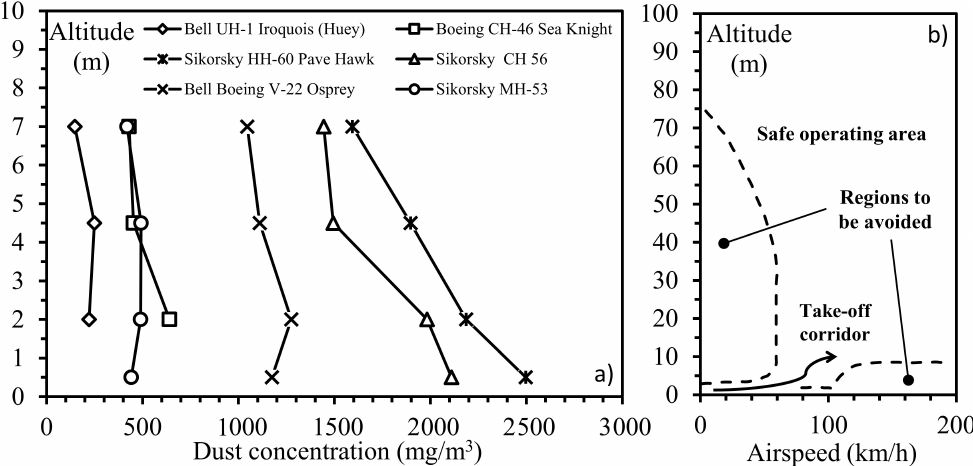
Figure 1. Operative conditions of a rotorcraft: ( a ) dust concentration profiles over altitude for six helicopter frames [8]; and ( b ) qualitative reproduction of the height-velocity curve of the Sikorsky S-76 helicopter, adapted from